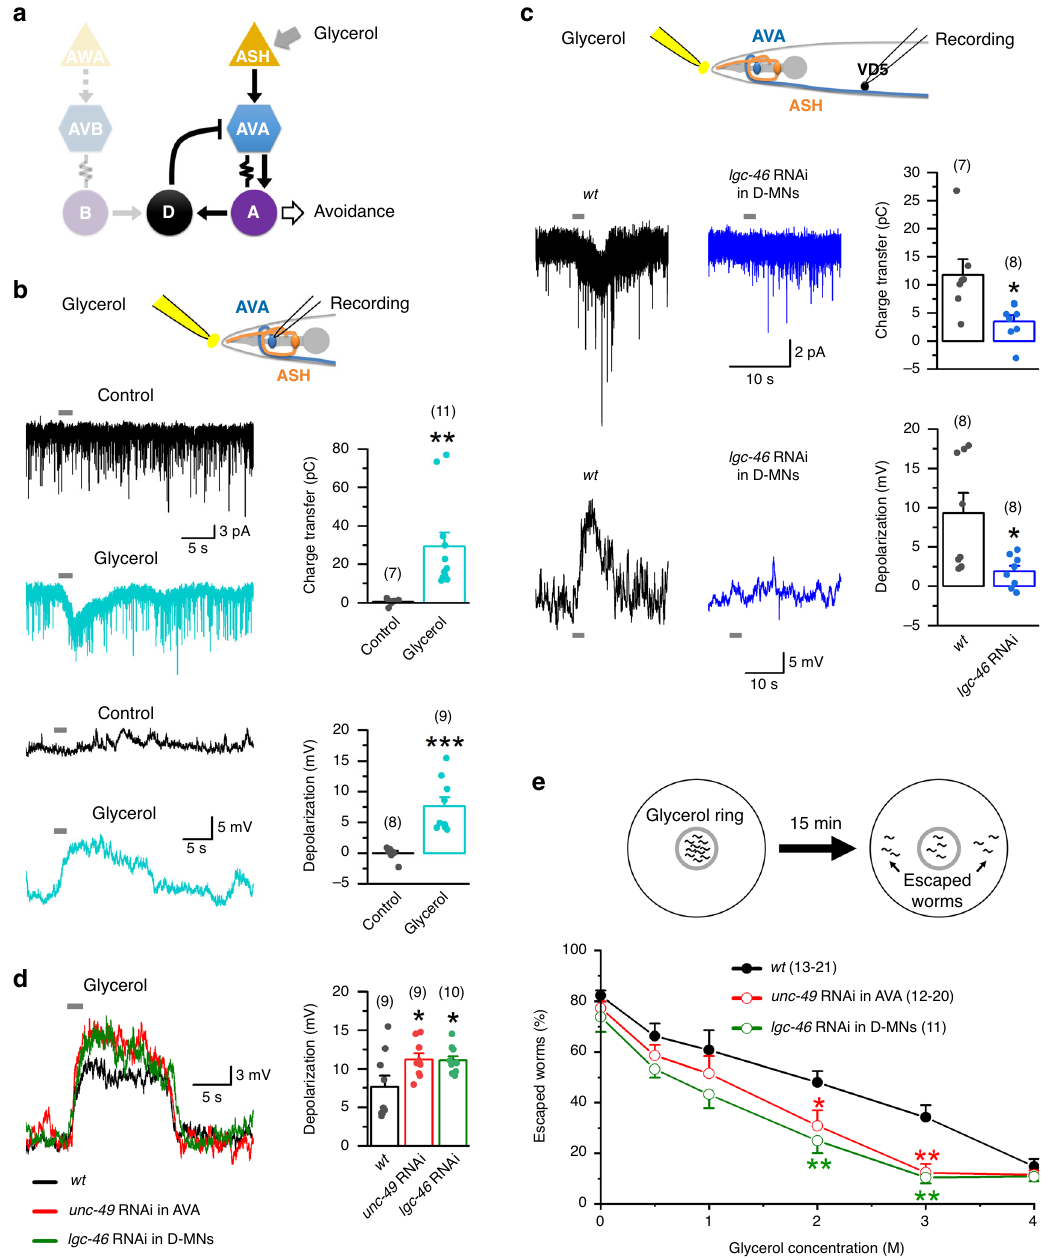
Fig. 4 The D-AVA circuit suppresses avoidance response to noxious hyperosmolarity. a Diagram depicting a simpli fi ed neural circuit for hyperosmolarity avoidance. b Application of a hyperosmotic glycerol solution but not the bath solution (control) caused inward current in AVA (held at − 60 mV) and depolarization of AVA. Compared with control, p = 0.006 charge transfer, and 0.000 depolarization. c Knockdown of lgc-46 in GABAergic neurons greatly abated glycerol-induced inward current in VD5 and depolarization of VD5 compared with wild type ( wt ). Compared with wt, p = 0.012 charge transfer, and 0.014 depolarization. d , e Knockdown of either unc-49 in AVA or lgc-46 in GABAergic neurons augmented glycerol-induced AVA depolarization ( d ), and reduced escape probability from a hyperosmotic glycerol barrier ( e ). In d , compared with wt , p = 0.046 unc-49 RNAi, and 0.047 lgc-46 RNAi. In e , 10 – 15 worms were placed inside a glycerol ring (diameter about 1 cm), and the percentage of worms escaped in 15 min was quanti fi ed. The effect of only one concentration of glycerol was tested in each experiment. In b – d , glycerol solution (2 M) was applied to the vicinity of the nose through a puf fi ng pipette. The asterisks indicate signi fi cant differences (* p < 0.05, ** p < 0.01, *** p < 0.001) compared with either the control or wild type ( wt ) based on unpaired two- sided t -test ( b, c ), or one-way ANOVA with Tukey ’ s post hoc ( d, e ). The numbers inside brackets indicate sample size ( n ). n = numbers of independently recorded cells in b – d , but numbers of individual worms in e . In e , sample sizes of the wt and unc-49 RNAi groups varied among different glycerol concentrations. For wt , n = 13, 15, 16, 21, 16, and 16 for the concentrations of 0 – 4 M. For unc-49 RNAi, n = 16, 20, 12, 12, 12, and 20 for the concentrations of 0 – 4 M. Data are presented as mean values ± SEM. Source data are provided as a Source data fi